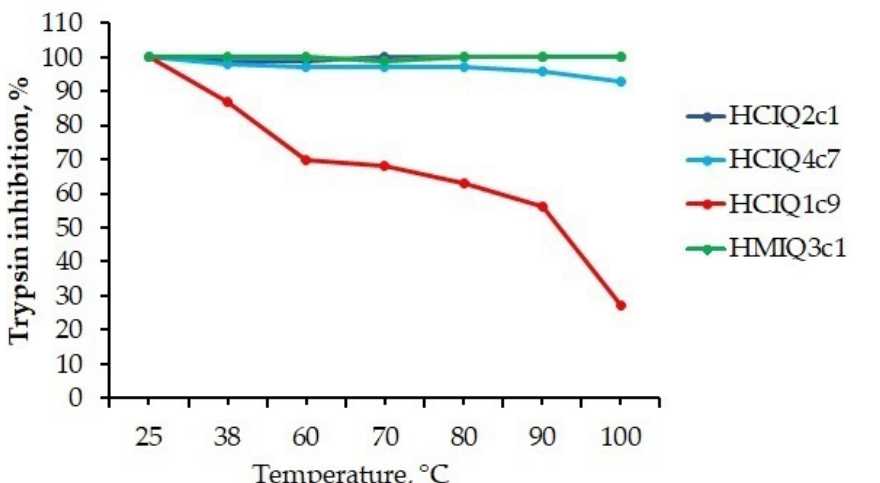
Figure 5. Evaluation of the thermal stability of peptides in deionized water via CD spectroscopy. Recordings of the CD spectra of HCIQ2c1 ( a ), HMIQ3c1 ( b ), HCIQ4c7 ( c ), and HCIQ1c9 ( d ) were conducted in the far UV region (190–240 nm) after the solutions were incubated over a temperature range from 25 °C to 100 °C for 20–25 min.